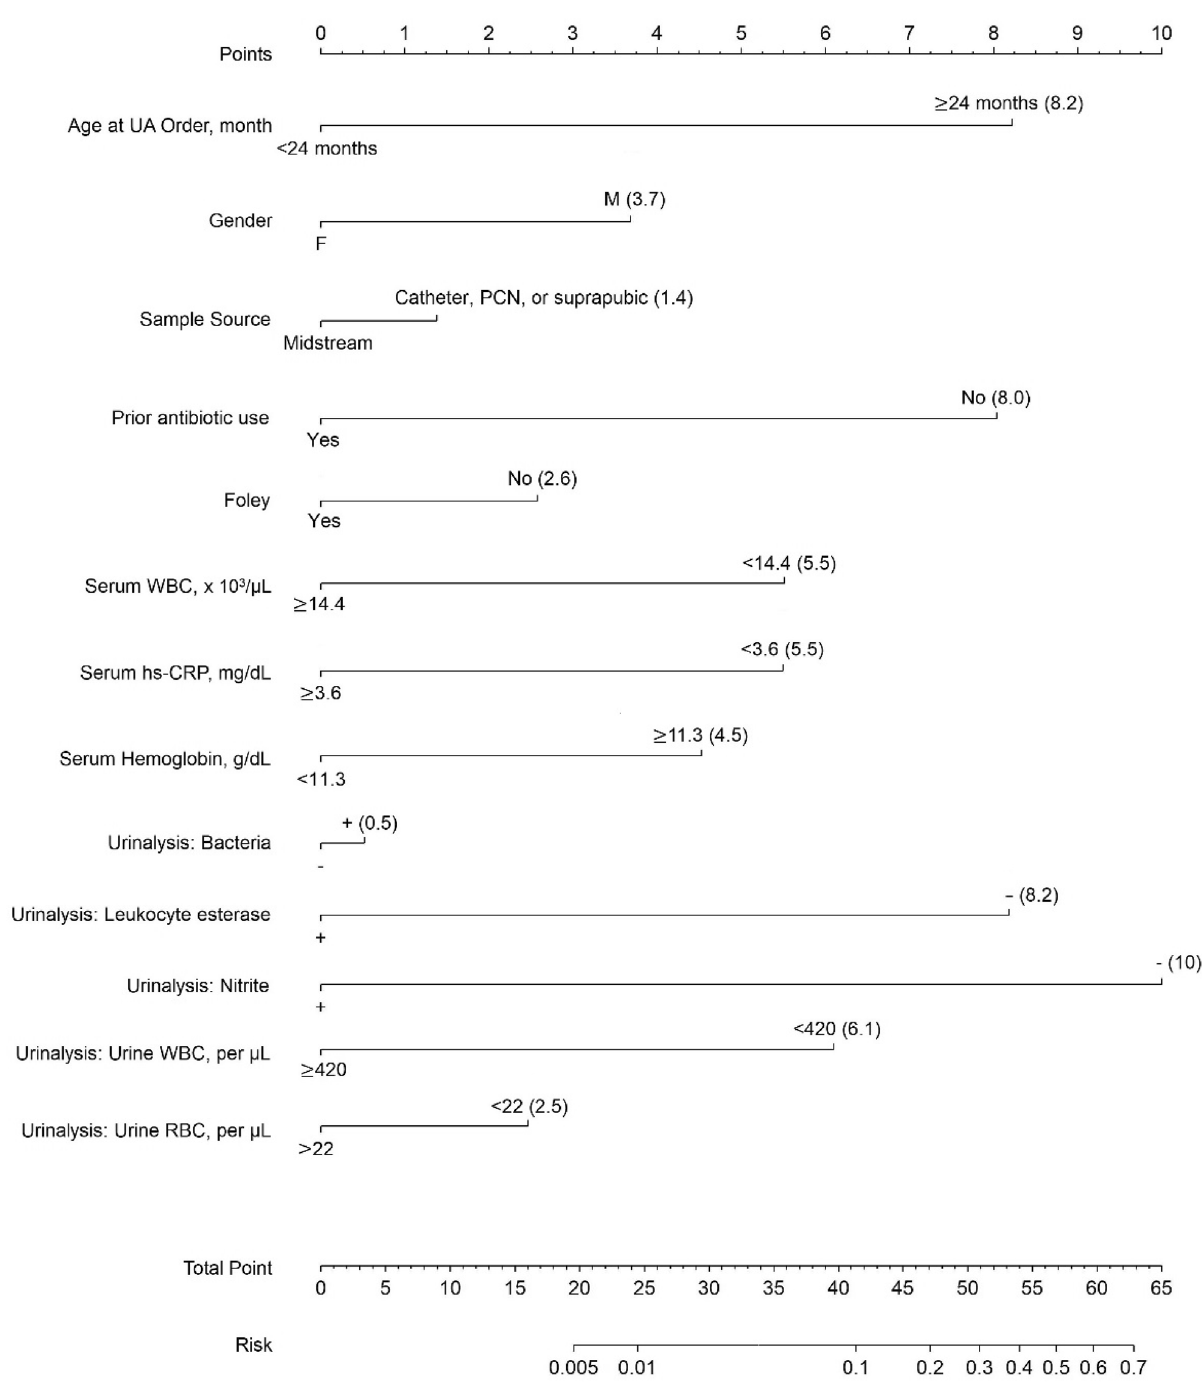
Figure 3. Nomogram of the prediction model for pediatric urinary tract infections caused by gram-positive